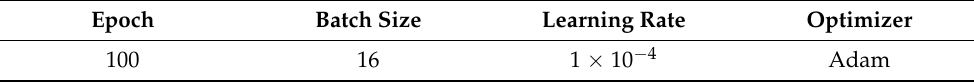
Table 4. Specific parameters.